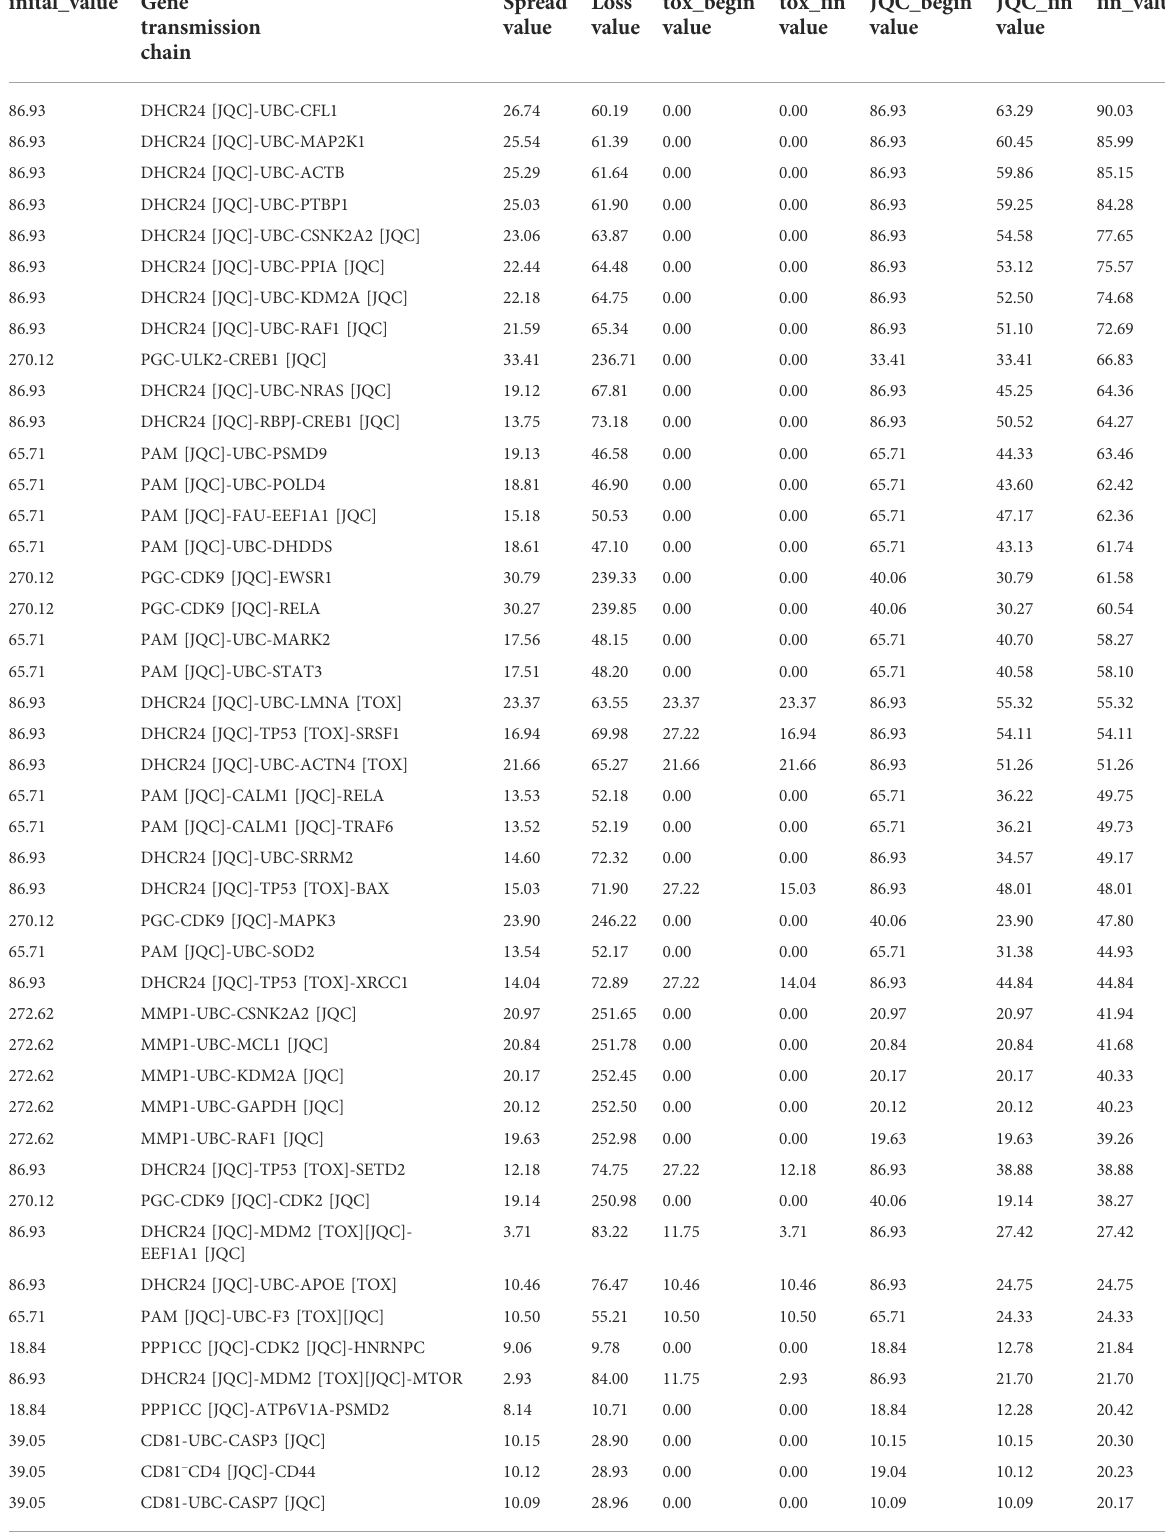
TABLE 3 50 representative